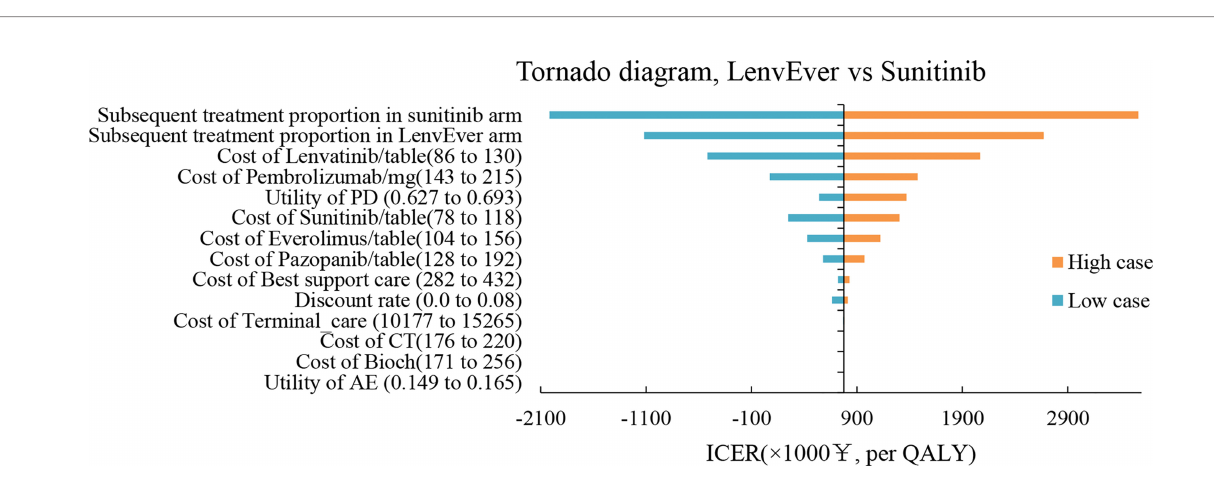
FIGURE 4 | Tornado Diagrams Showing the Effect of Lower and Upper Values of Each Parameter on the ICERs of the Lenvatinib-plus-Everolimus Versus Sunitinib